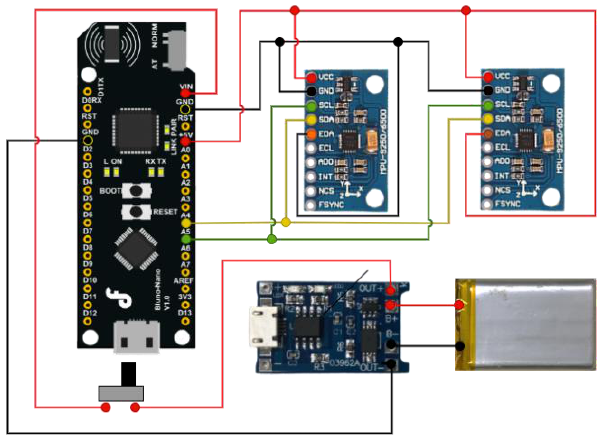
Figure 2. ROMSS hardware architecture.